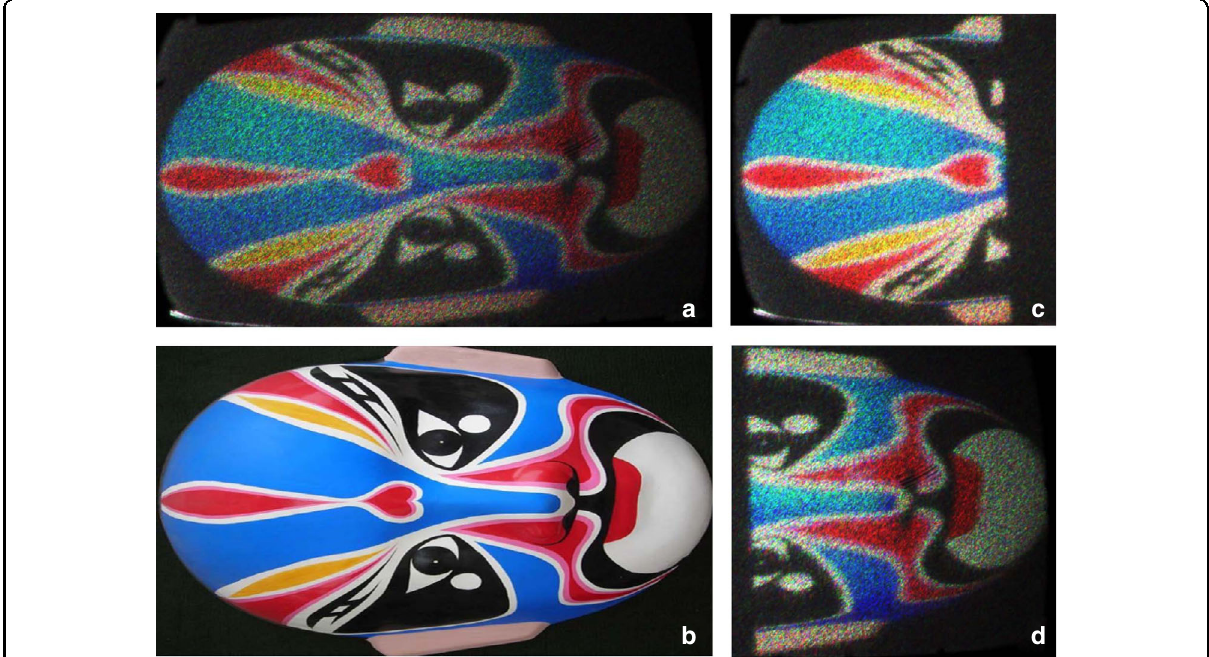
Fig. 5 Holographic display results of the two spatially tiled holobricks. a Reconstructed holographic images with two holobricks, b the original image, c reconstructed holographic images of fi rst holobrick, and d reconstructed holographic images of second holobrick. Each holobrick displays a half part of the whole object and two holobricks display a large-size holographic